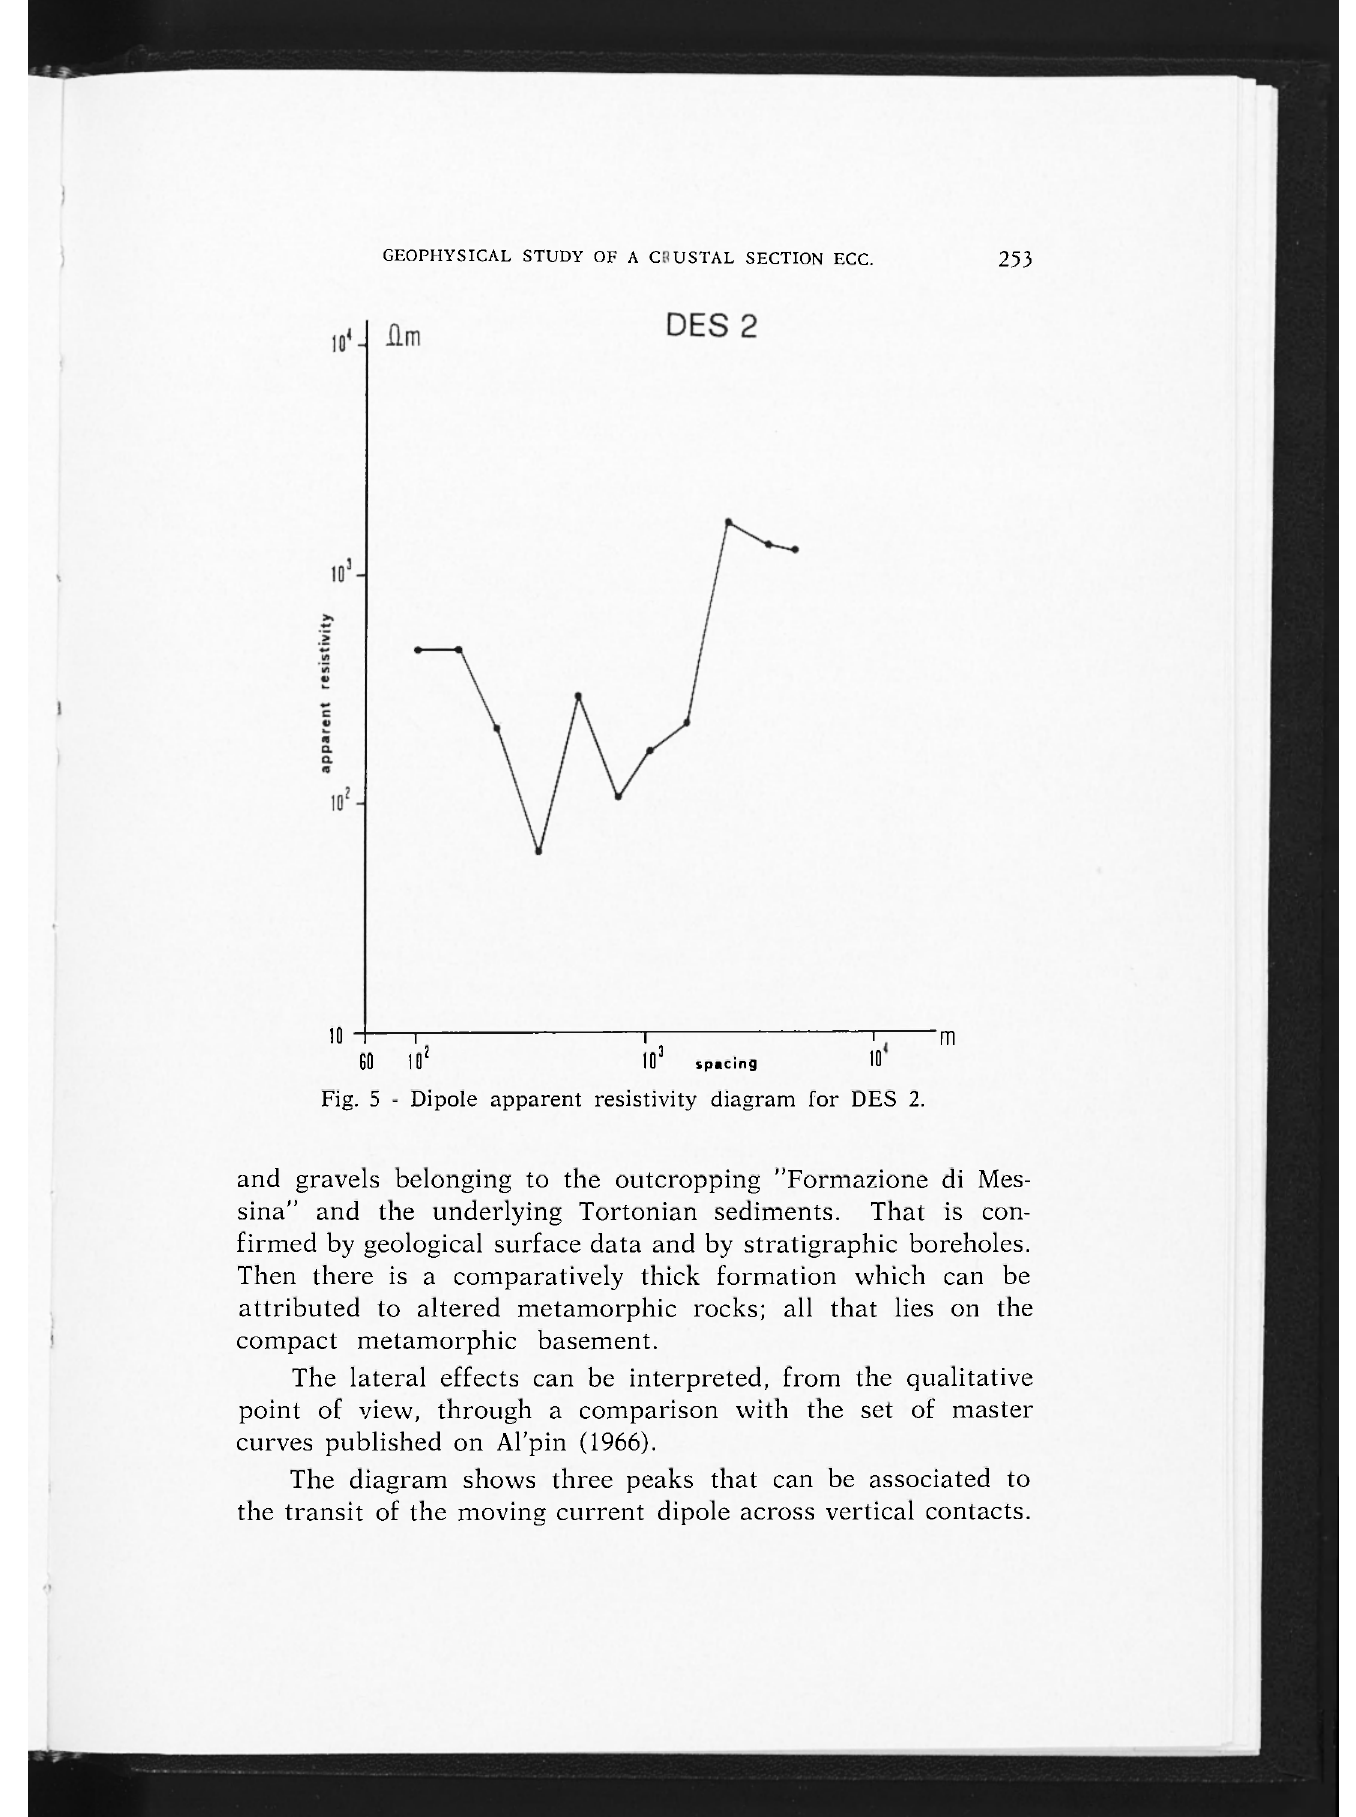
Fig. 5 - Dipole apparent resistivity diagram for DES